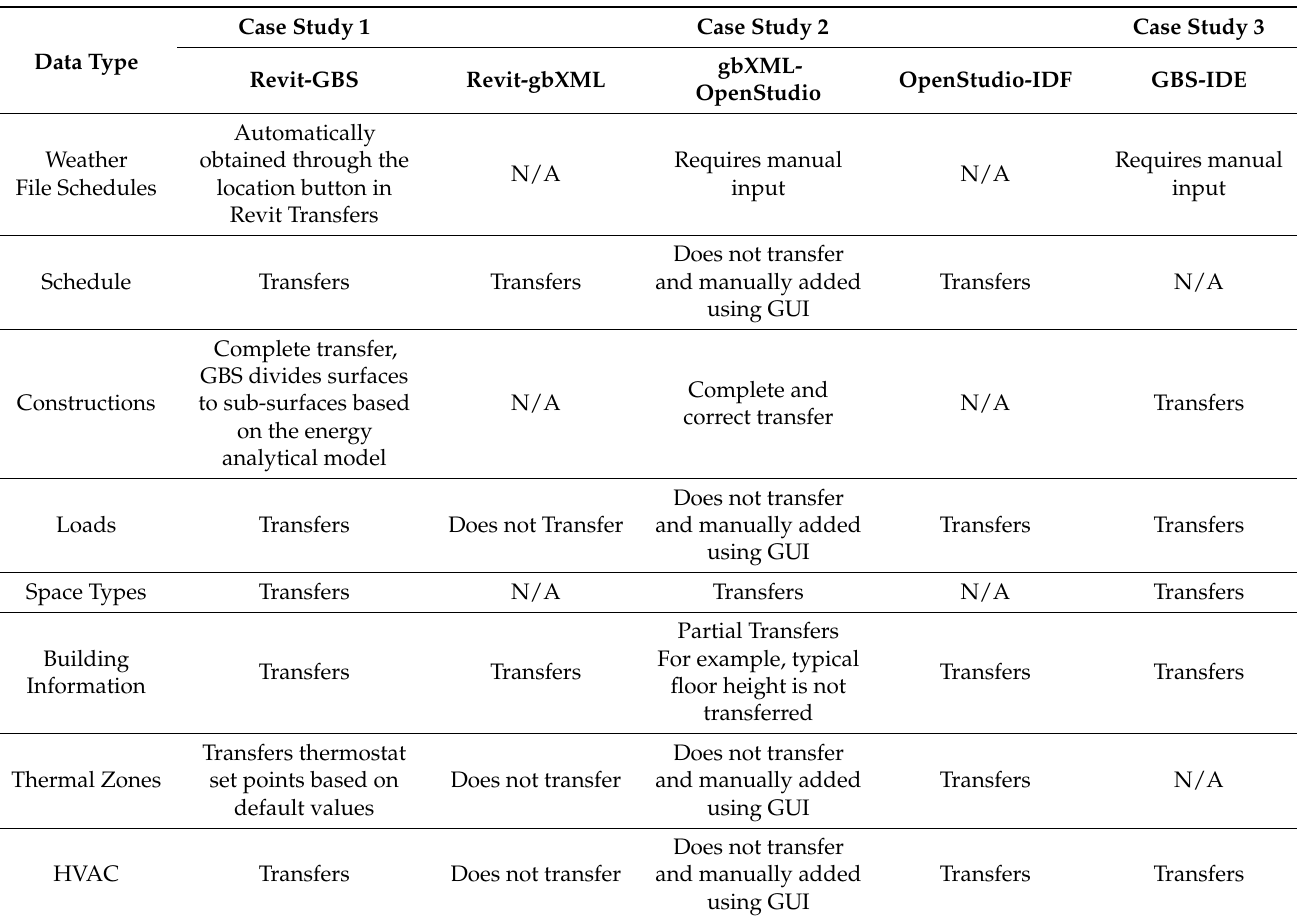
Table 1. Data transfer issues between different BIM tools